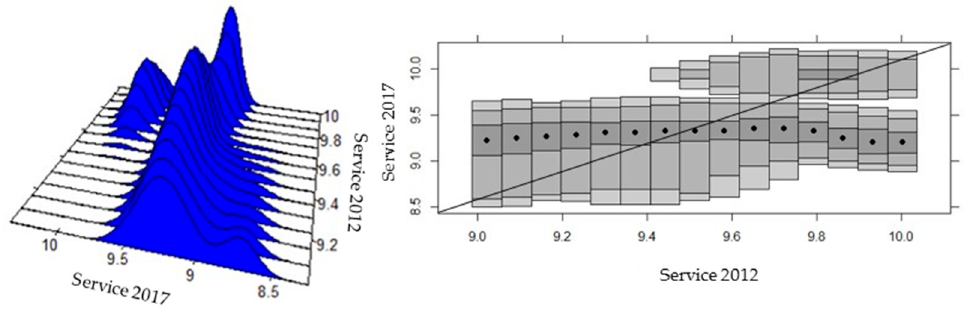
Figure 8. Intra-distribution dynamics of provincial productivity in the service sector, 2012–2017. Source: Own elaboration based on the Regional Accounts of the BCE [46]; ENEMDU surveys from the INEC [47] (several years) and stacked conditional density plot (SCD) in R.